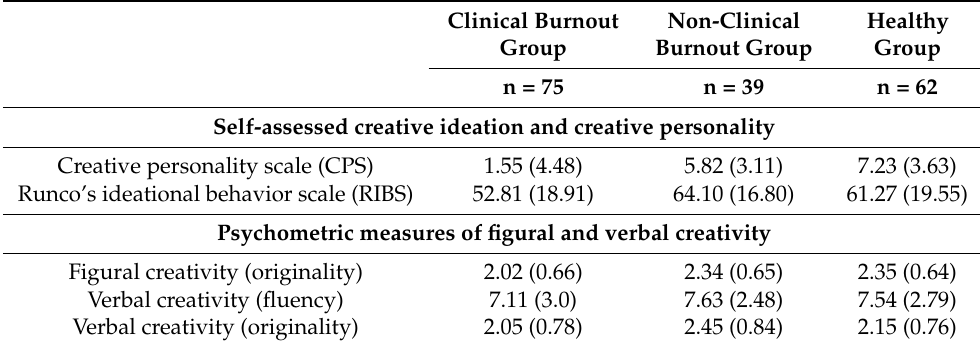
Table 3. Self-assessed creative ideation and creative personality, as well as psychometric measures of figural and verbal creativity.